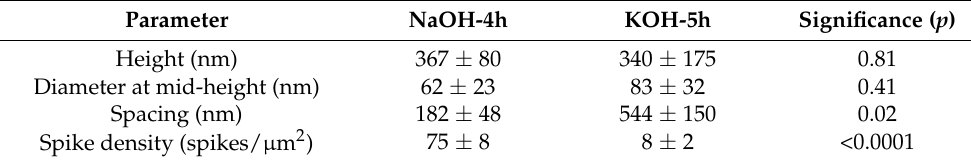
Table 1. Topography dimensional comparison between NaOH-4h and KOH-5h. Parameter NaOH-4h KOH-5h Significance ( p